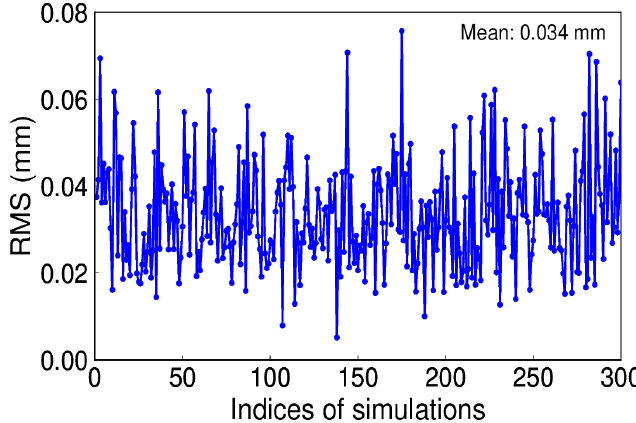
Figure 9. RMS of extracted and simulated signal with power-law noise.